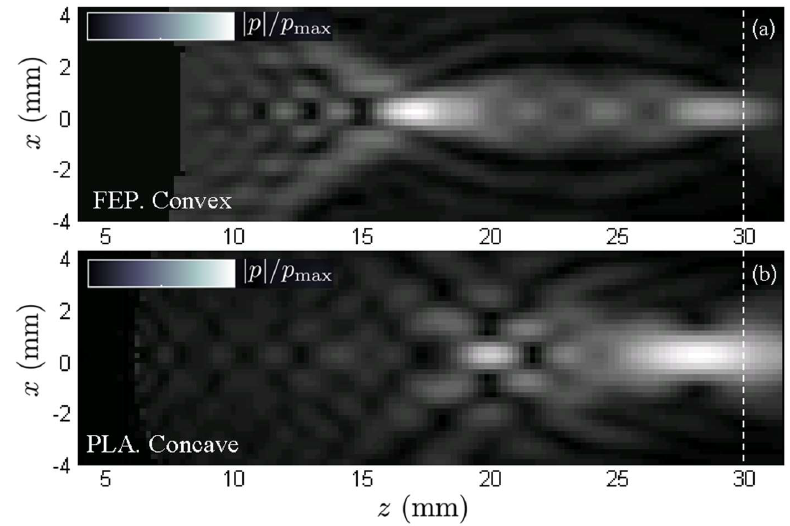
Figure 10. Numerically simulated pressure field distributions in the sagittal plane, P (x,z), obtained with two lenses generated from the same particular registered pattern. ( a ) Convex lens made of fluorinated ethylene propylene and ( b ) concave lens made of polylactic acid.